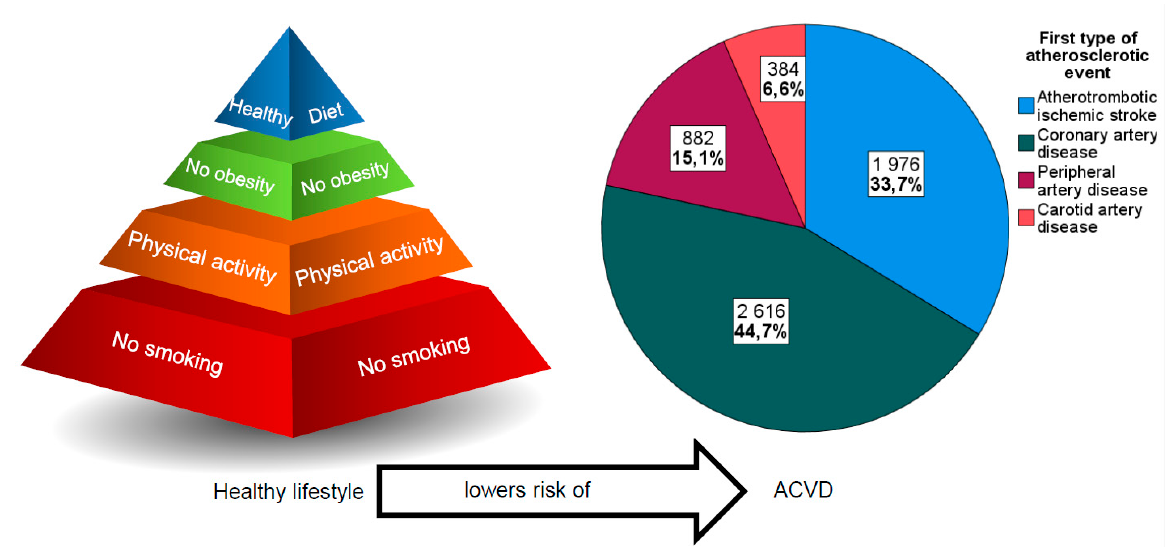
Figure 2. Graphical schematic presentation of the main results of the study, where no smoking has the largest reduction in risk of the modifiable risk factors for atherosclerotic cardiovascular disease (ACVD). Table 1. Baseline characteristics of study participants with and without incident atherosclerotic cardiovascular disease in the MDCS cohort.